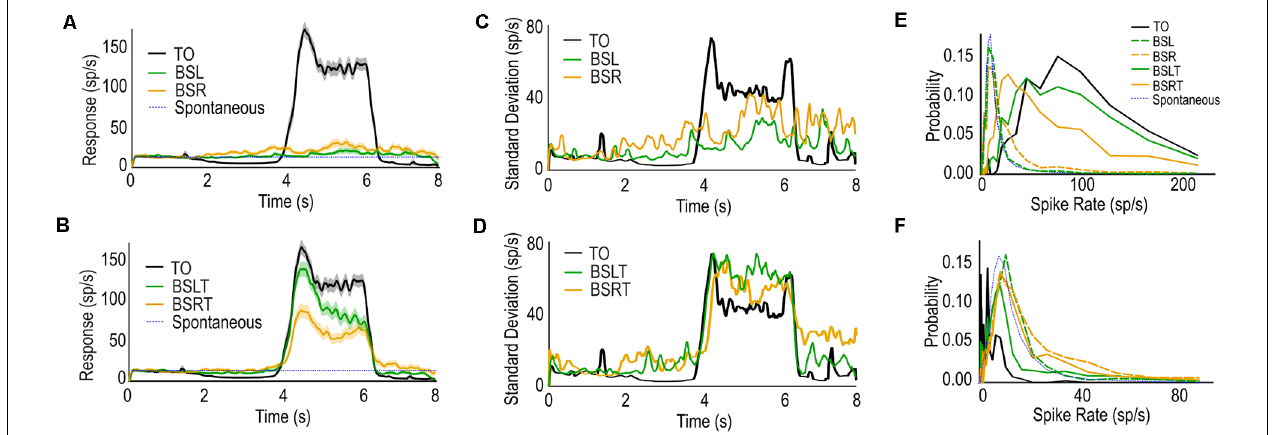
FIGURE 3 | (A) Mean spike-rate and standard error (shaded regions) of CSTMD1 to TO, BSL, and BSR. Backgrounds alone produce modest spike rate increases. (B) as (A) for TO, BSLT, and BSRT. Targets with leftward or rightward backgrounds result in robust, but reduced spike-rates. (C) Standard Deviation of responses calculated over time TO, BSL, and BSR. Backgrounds alone (BSL/BSR) result in increased variation of spike rate. (D) as (C) for TO, BSLT, and BSRT (right). When the background is presented with the target (BSLT/BSRT) the variation in both the inhibitory and excitatory receptive fields are increased despite lower overall inhibition or excitation. (E) Weighted Histogram of Interspike Intervals of each condition over 4.25–4.75 s window (during target excitatory phase). (F) as (E) but 3.25–3.75 s window (during the target inhibitory